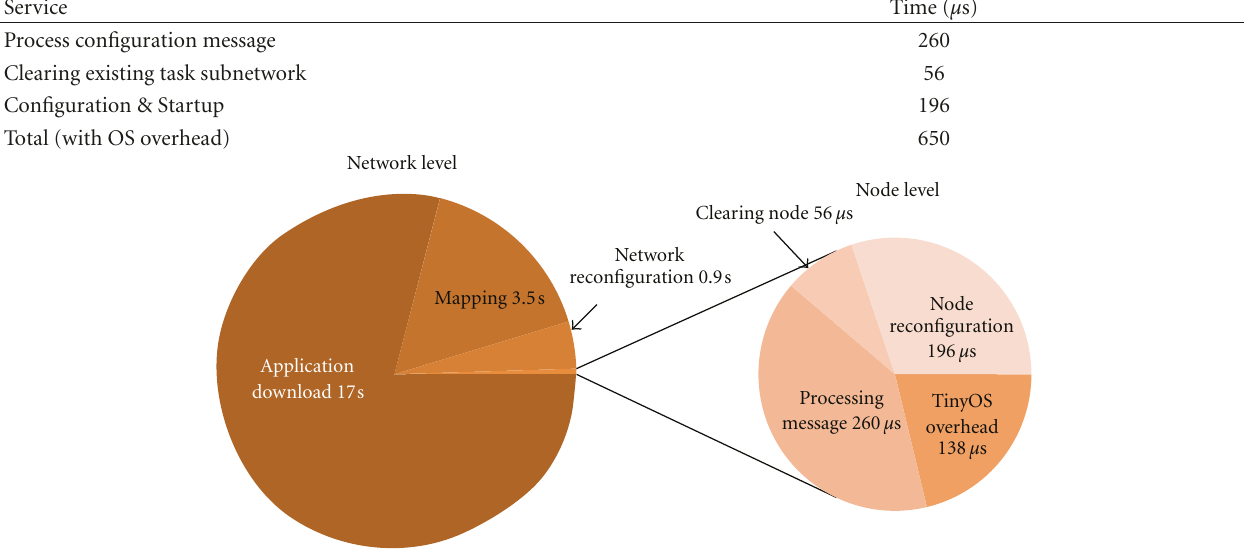
Table 4: Analysis of the reconfiguration process comparing the node level timings to the application instantiation results of Section 4.2.1. Service